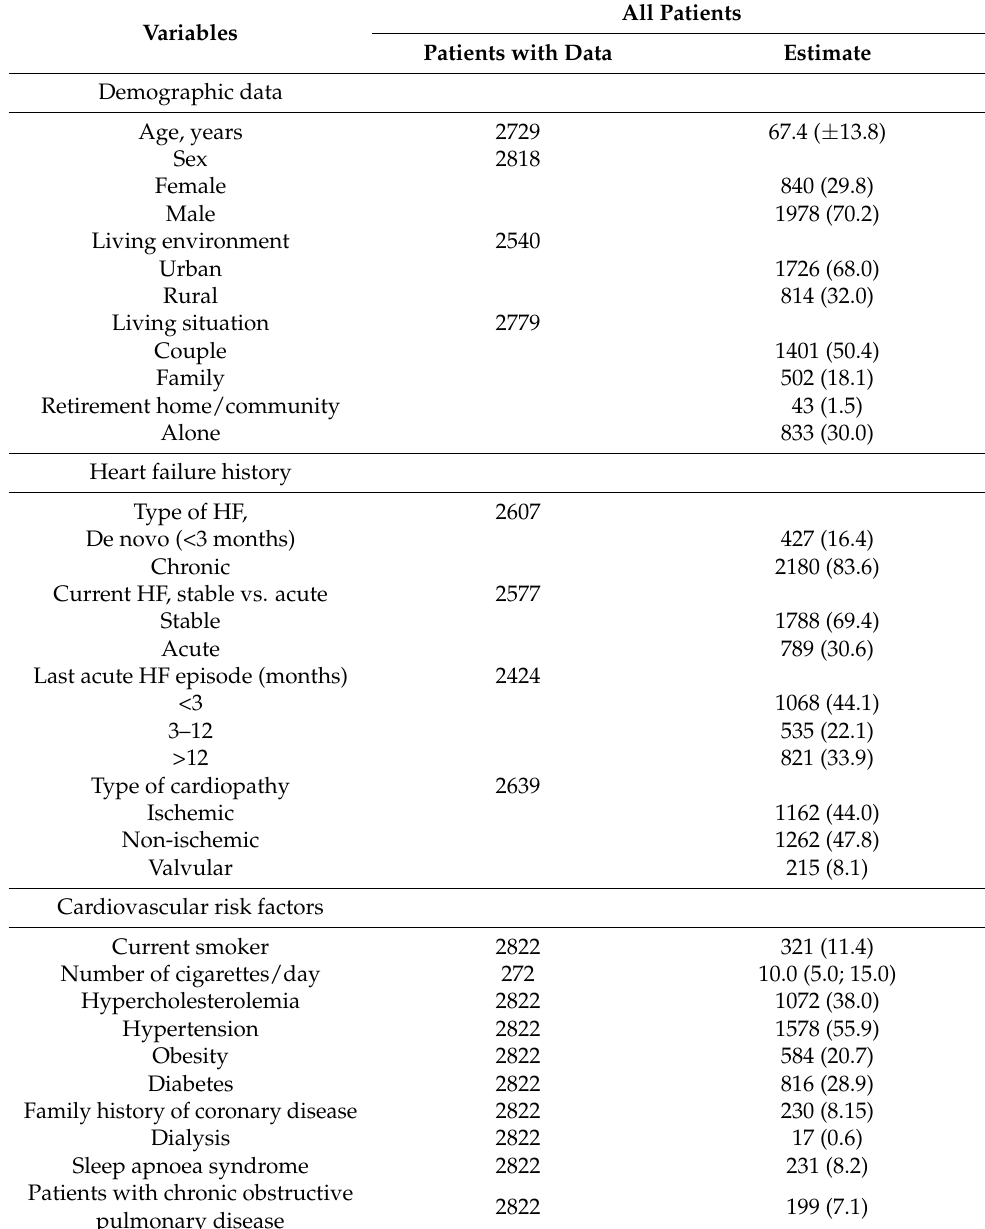
Table 1. Demographic, clinical, and biological characteristics of HF patients enrolled in the OFICSel observatory ( n =